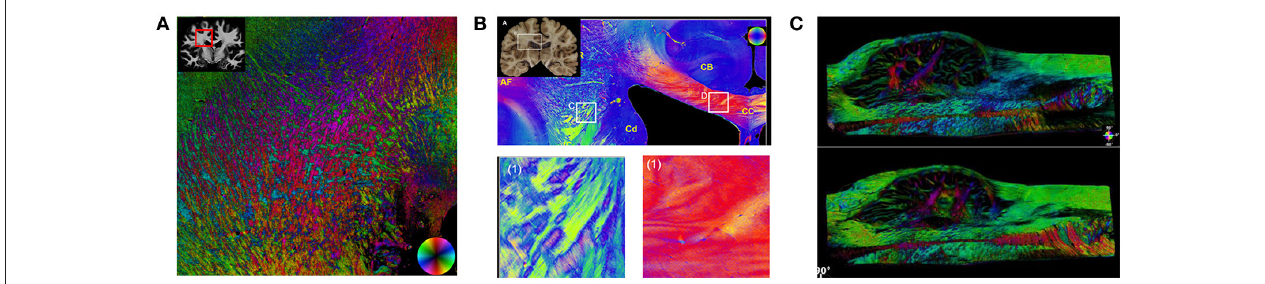
FIGURE 3 | Fiber Orientation Measurements in Fixed Tissues. Examples of fiber orientation measurements in human brain specimens. Structure tensor analysis (A) uses a digital texture analysis method to detect fiber orientations in stained sections imaged with bright-field or fluorescence microscopy. Both polarized light imaging (B) and polarization-sensitive optical coherence tomography (C) exploit the intrinsic birefringence of myelin to obtain fiber orientations. Sections in (A) [114] and (B) [115] (reproduced under the Creative Commons Attribution License) are from the human brain white matter, and (C) [116] from the human medulla oblongata (with